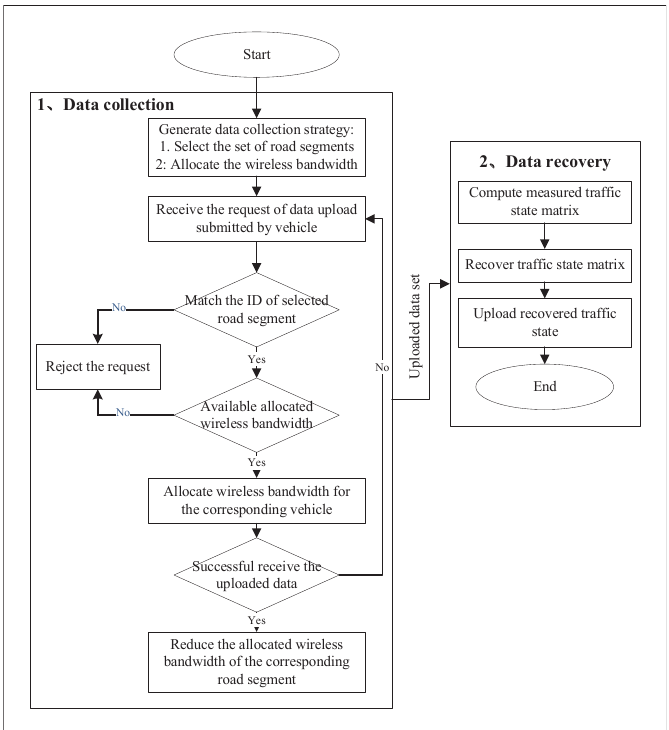
Figure 2. Data Processing of the MEC